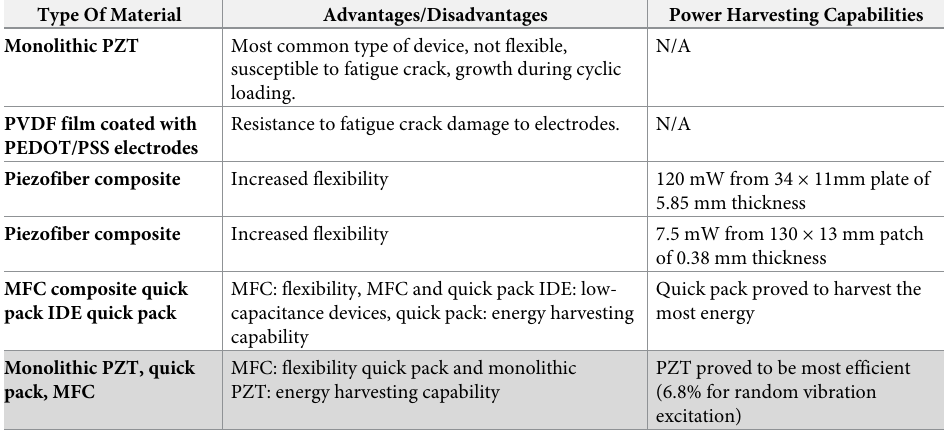
Table 2. Summary of some piezoelectric materials transducers’ investigation about their advantages and disad- vantages and their power harvesting capabilities [18] [19]. Type Of Material